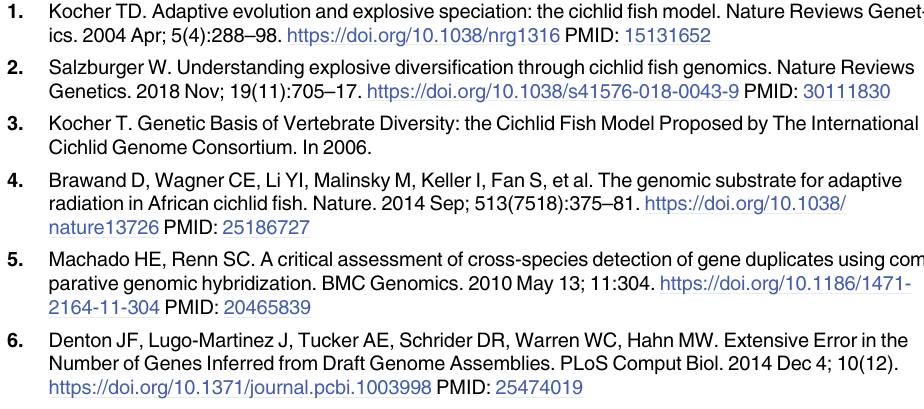
S1 Table. Gene probe information. S2 Table. Nucleotide composition PCA output & pairwise MANOVA results.